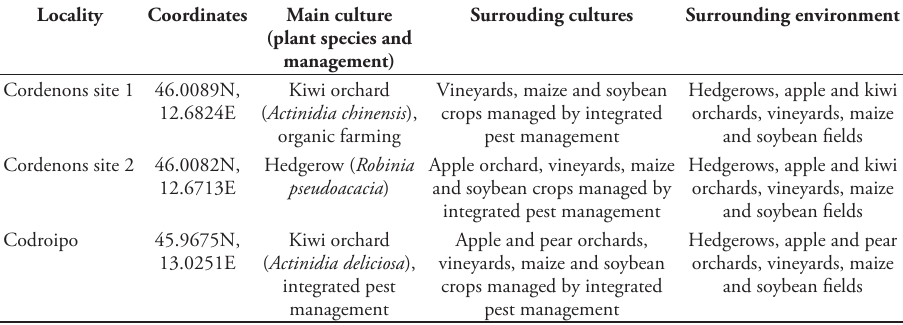
Table 1. Descriptions of Trissolcus mitsukurii recovery sites in northeastern Italy.